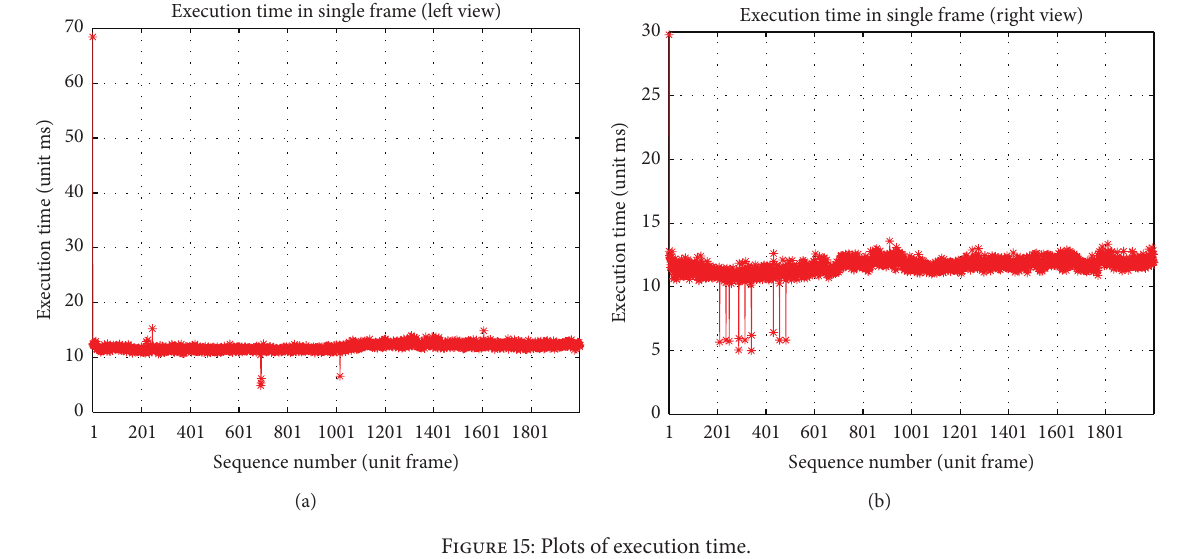
Figure 15: Plots of execution